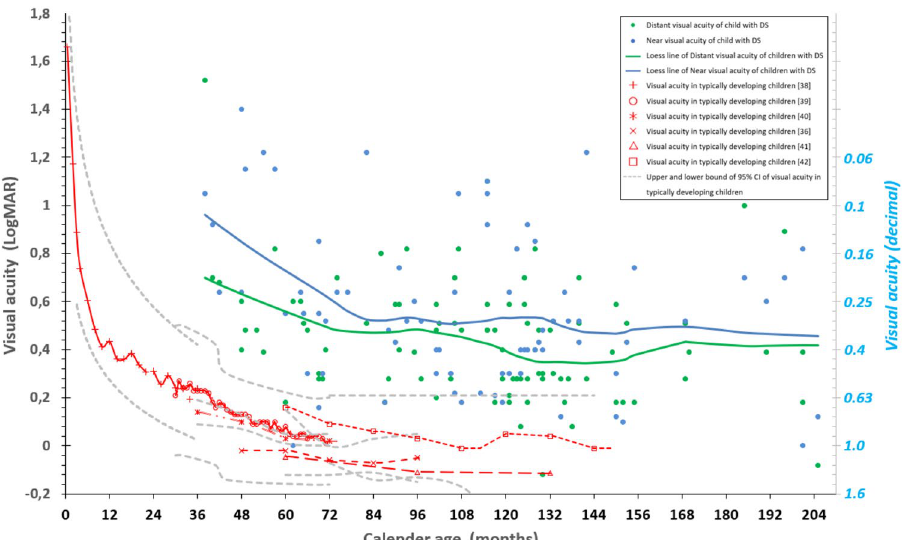
Figure 4. Visual acuity. Normative data from typically developing children (age 0–12 years) are shown in red 70 with upper and lower bound of the 95% confidence interval in grey dashed lines (extracted from the separate original studies 70 ). Note that before the age of 30 months, visual acuity could be estimated only with a preferential looking test such as the Teller acuity chart (TAC) 71 . From the age of 30 months, visual acuity could be assessed with symbols the child named, gestured or matched. Distant (green) and near (blue) visual acuity in our cohort of children with DS as a function of calendar age. Solid lines are Loess lines fitted to the data. Note the gradually improving visual acuity of children with DS and typically developing children. The acuities of the children with DS lie above the norm scores indicating that children with DS scored poorly on visual acuity, near visual acuity being even worse than distant visual acuity (mean difference 0.11 ± 0.32, paired t-test t(73) = -2.900, p = 0.005). Normative distant visual acuities were obtained from: Salomao et al. 38 , (TAC, n = 646, 0–30 months, red crosses), Pan et al. 39 (HVOT, n = 1722, 30–72 months, red circles), Lai et al. 40 (Landolt-C, n = 212, 3–6 years, red stars), Huurneman et al. 35 (Tumbling E, n = 75, 4–8 years, red x-es), Jeon et al. 41 (Tumbling E, n = 78, 5–11 years, red triangles), Dobson et al. 42 (ETDRS, n = 252, 5–12 years, red squares). Grey dashed lines: upper and lower bound of the 95% confidence interval of the original norm